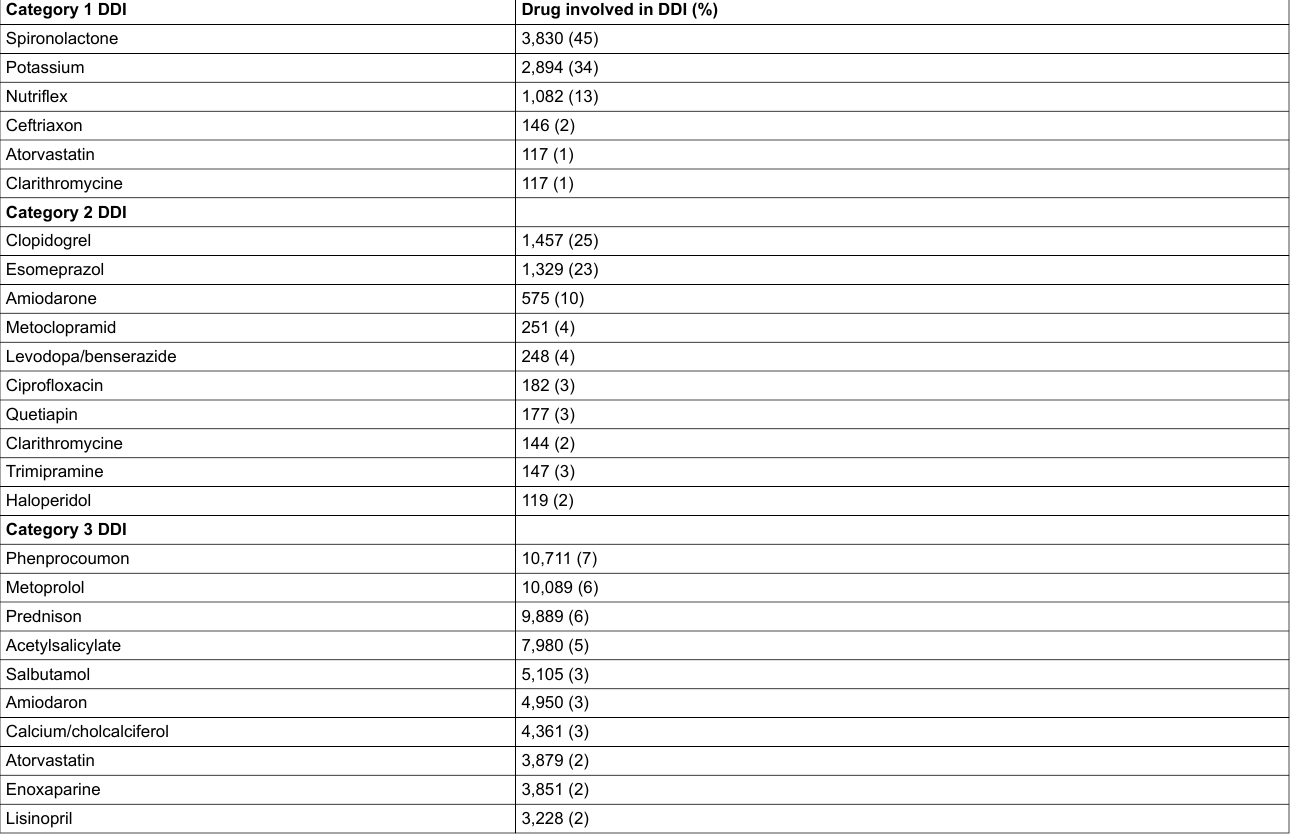
Table 4 The most frequent drugs involved in DDI alerts within the DDI categories 1–3 and during 2010 are outlined. In category 1, drugs creating more than 50 DDI-A are indicated. In category 2 and 3 only the top ten drugs are